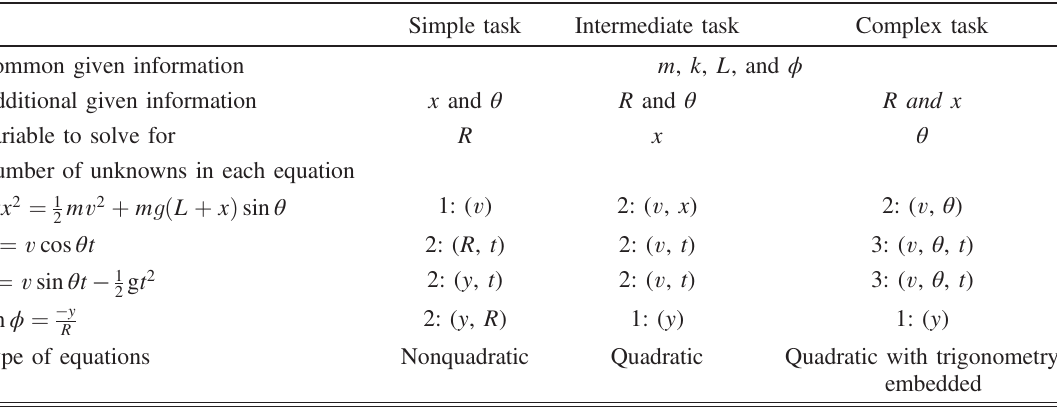
TABLE I. Known and unknown variables and types of equations across sequential synthesis tasks with increasing mathematical complexity ( m : mass of block, k : spring constant, L : equilibrium position, ϕ : angle of final